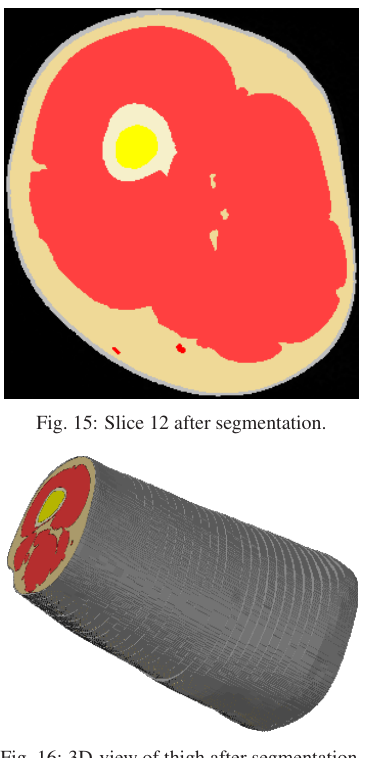
Fig. 16: 3D-view of thigh after